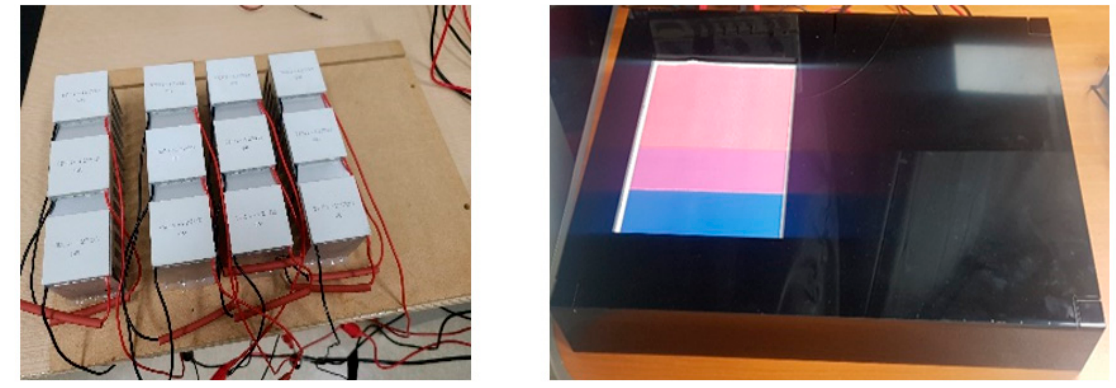
Figure 5. Peltier array and finished prototype with an artwork on top [88].